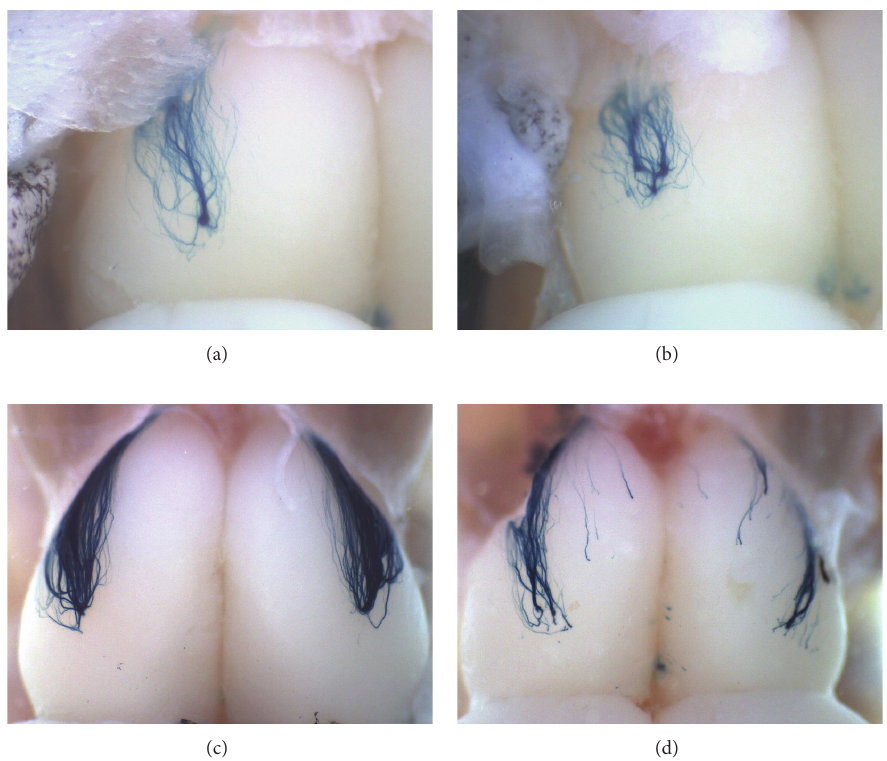
Figure 5: Chronic exposure to pure acetophenone influences the formation of M72tLacZ glomeruli in the OB. (a) A lateral M72 glomerulus in one OB of a 20-day-old M72tLacZ mouse. Typically, only one lateral glomerulus is formed in all mice. (b) Formation of M72 supernumerary glomeruli after 20 days of acetophenone exposure from birth. (c) Regeneration of lateral M72 glomeruli in both OBs in a M72tLacZ adult mouse 45 days after methimazole treatment. (d) Dispersed and mistargeted M72 axons with no glomerular formation in an adult mouse exposed to acetophenone for 35 days after methimazole treatment (days